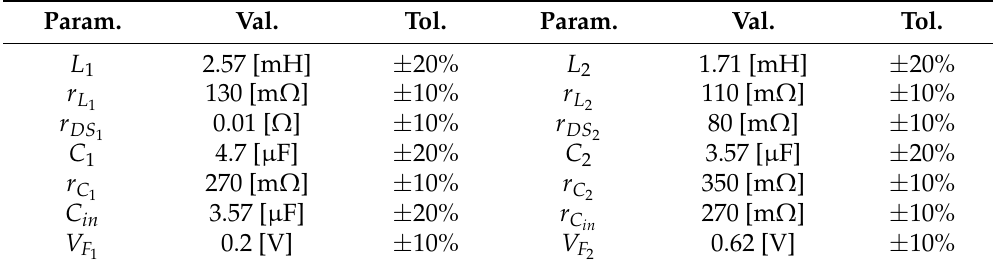
Table 2. Single-ended primary-inductor converter (SEPIC) converter parameters, values, and corre- sponding